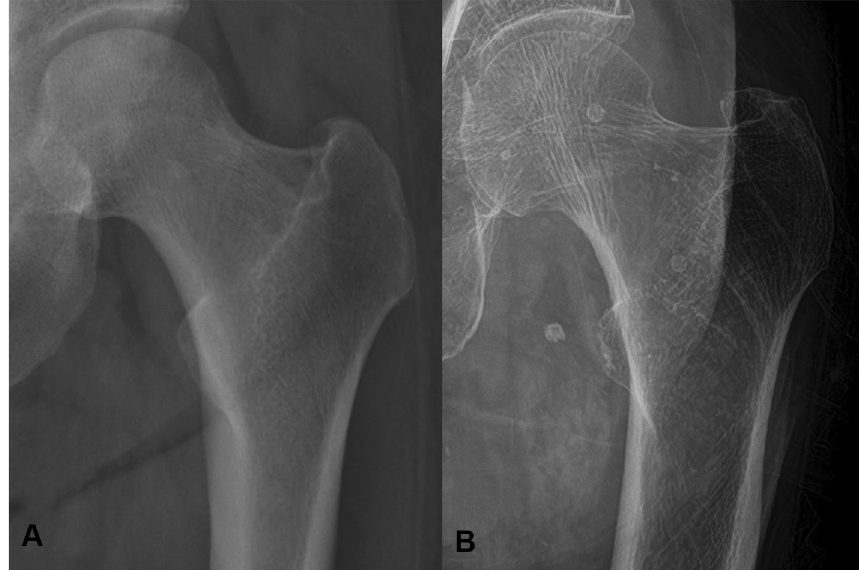
who was diagnosed with osteoporosis with T-score of − 4.6 is shown in ( B